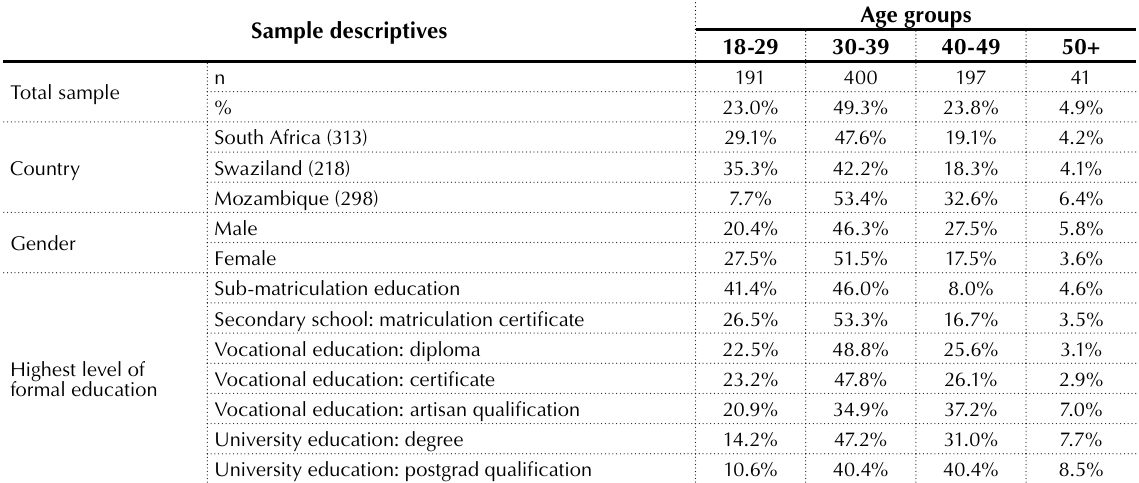
Table 2. Age groups